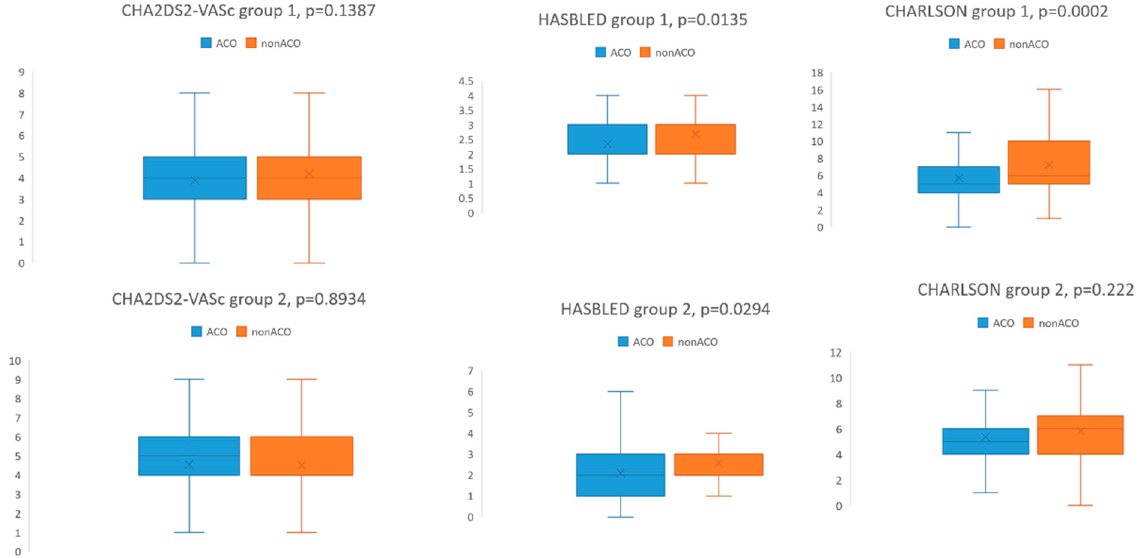
Figure 2. CHA 2 DS 2- VASc, HASBLED and Charlson comorbidity index in anticoagulated (ACO) and nonanticoagulated (nonACO) patients from group 1 and group 2, respectively.